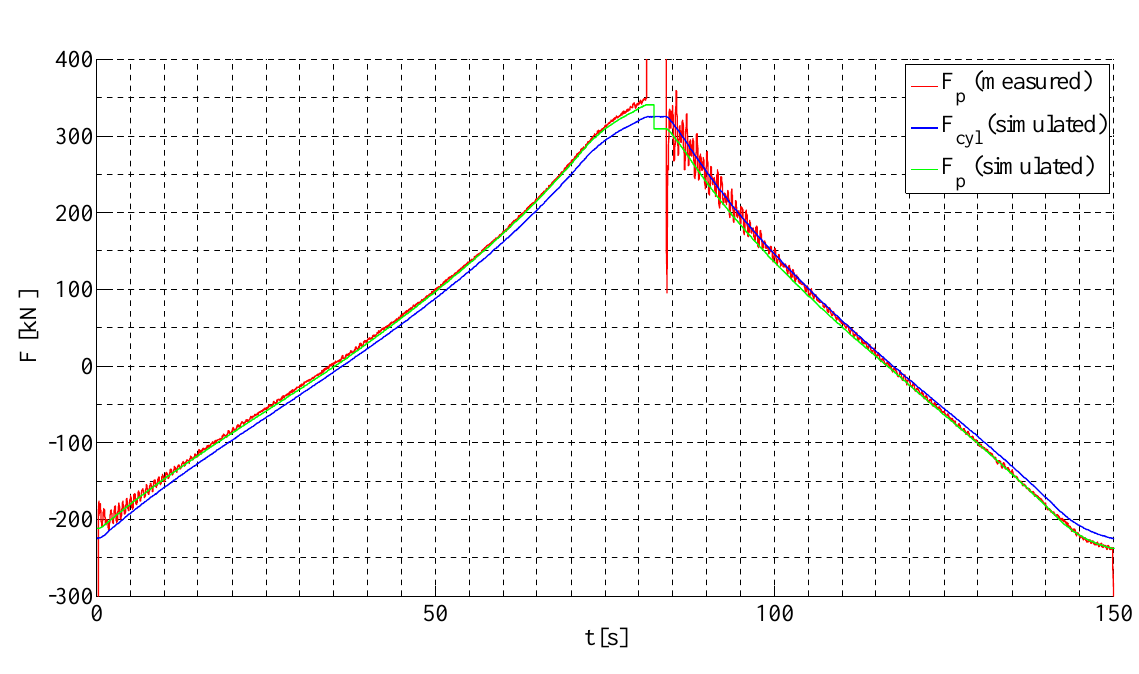
Figure 14: Measured and simulated forces for verification of steady-state characteristics.